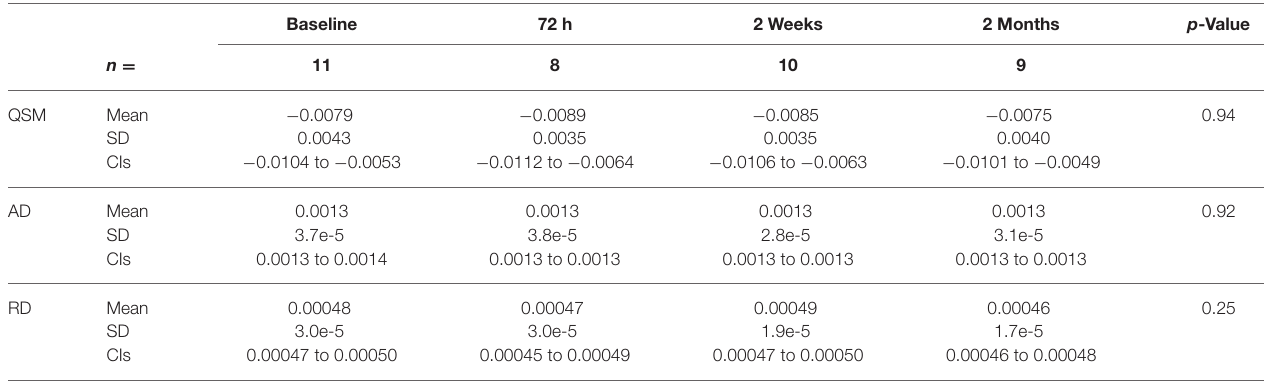
TABLE 1 | Mean QSM, AD, and RD values with standard deviations and confidence intervals.